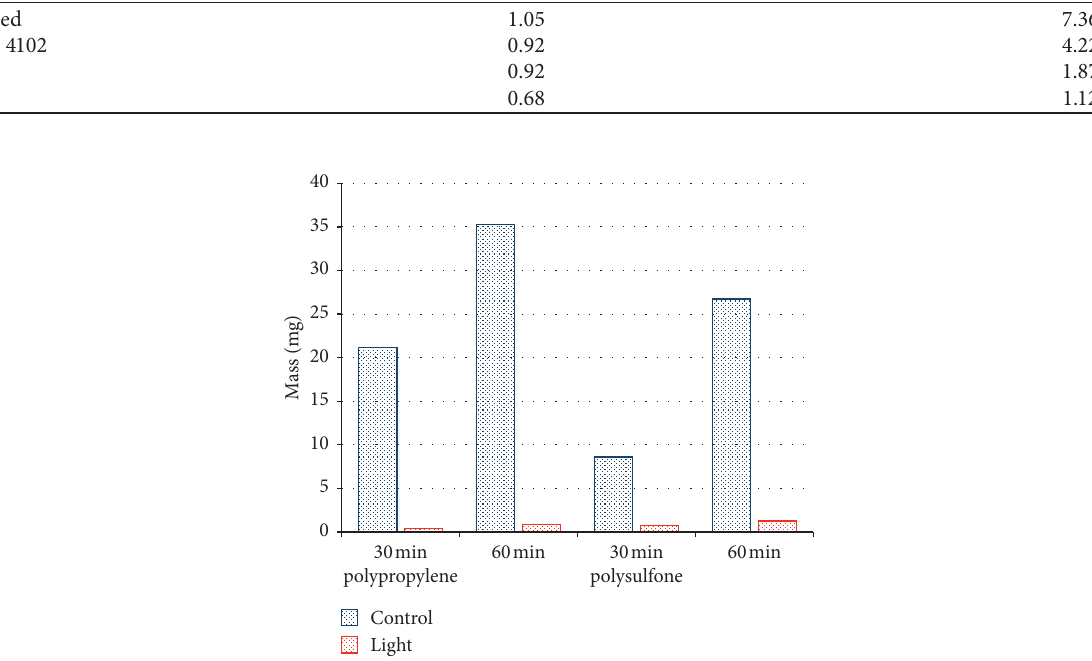
Table 2: Rate of calcium carbonate crystal growth for UV-treated and UV-untreated water. Water sample